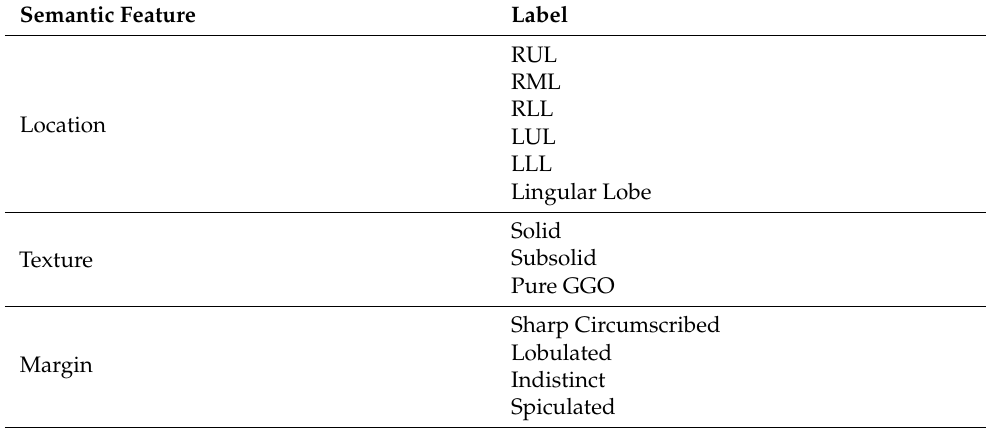
Table 1. List of labels for three types of semantic features. Semantic